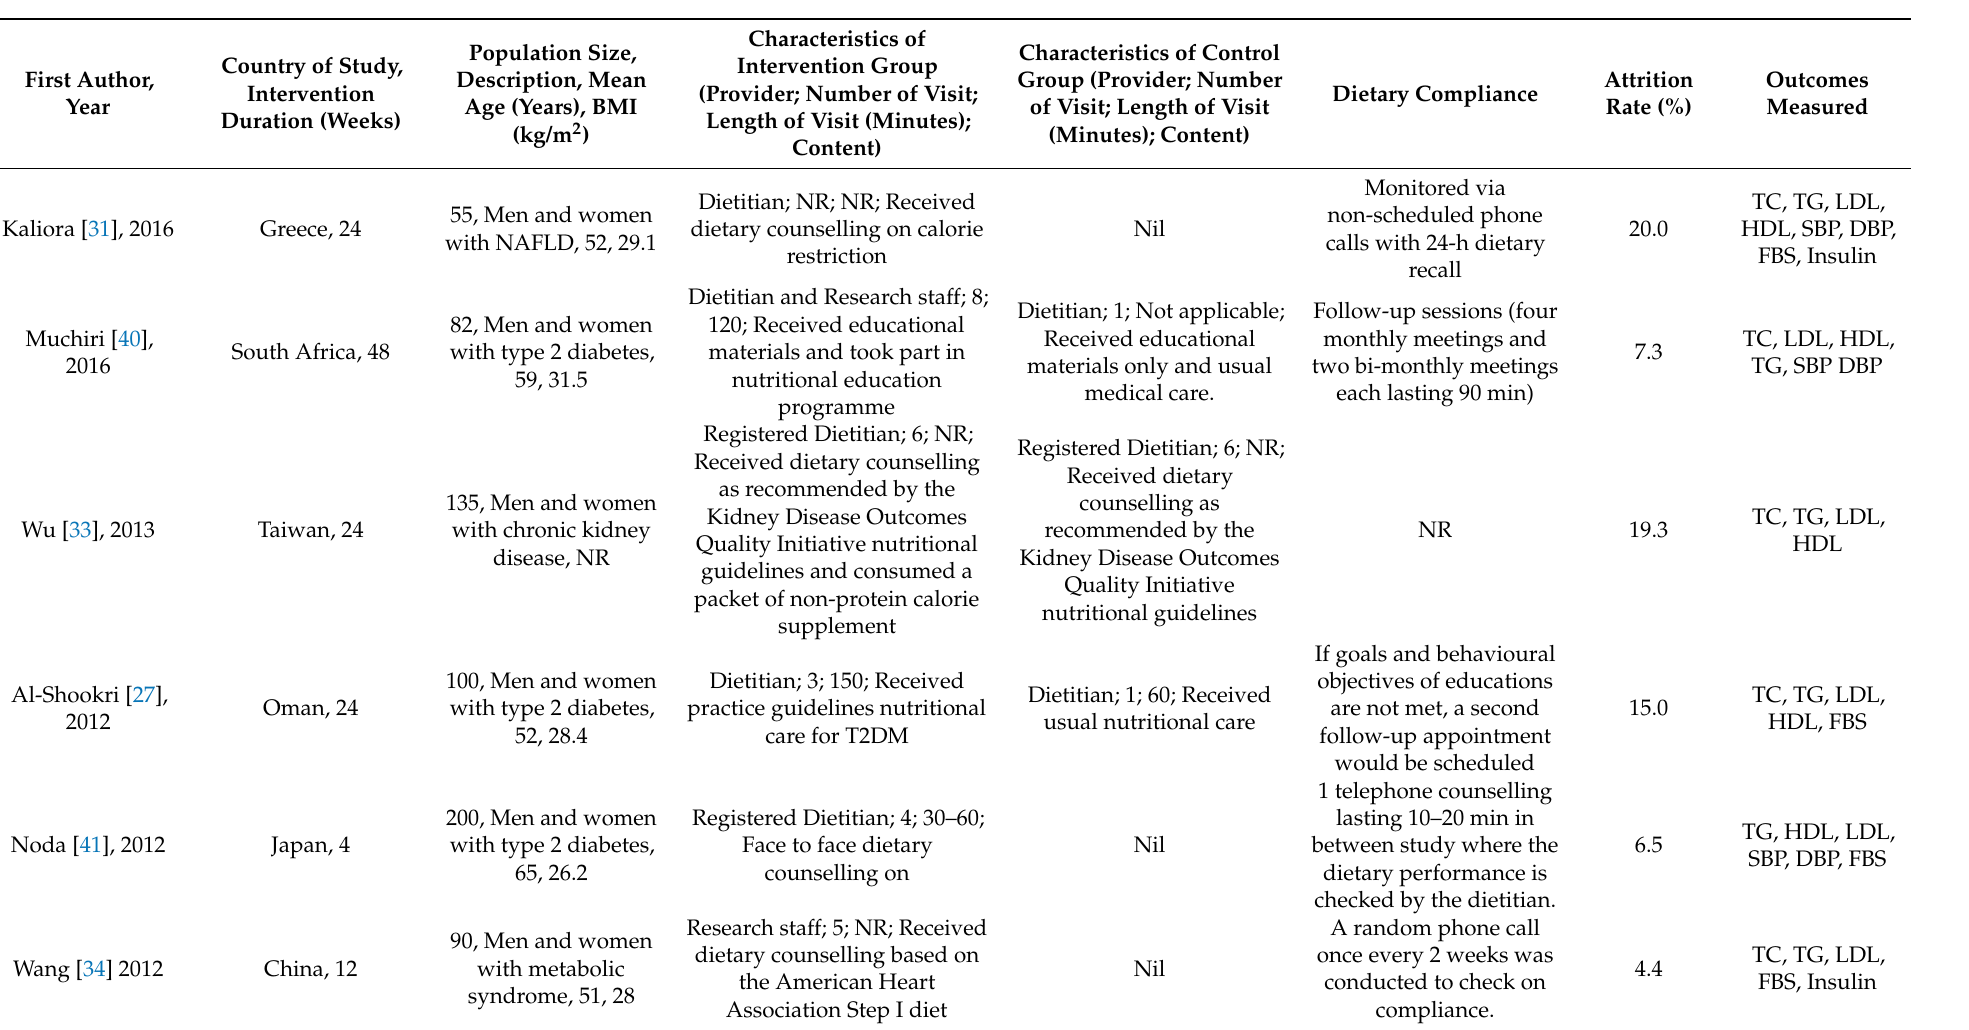
Table 2. Characteristics of the 22 included RCTs for systematic review and